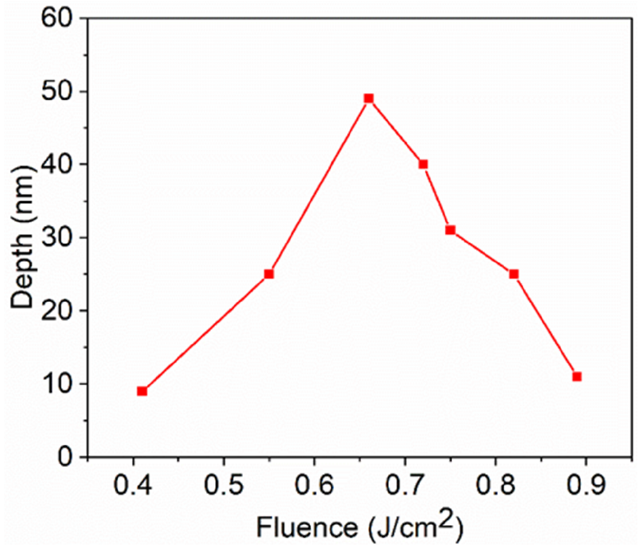
Figure 11. LSFL depth versus the pulse fluence at a constant scanning velocity of 3 mm/s.